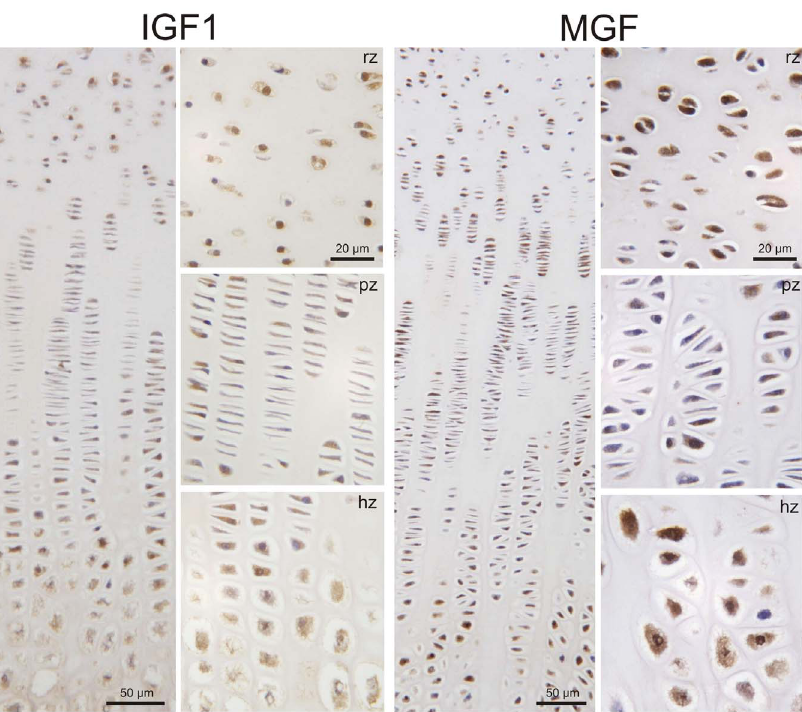
Figure 4. Immunohistochemical detection of MGF and IGF-1 in the porcine growth plate (overview, magnification 10x). MGF and IGF- 1 was detected in chondrocytes of the resting (rz), proliferating (pz) and hypertrophic (hz) zone of porcine growth plate. We found the MGF peptide in the cytoplasm and in some chondrocytes also in the nucleus of resting and hypertrophic chondrocytes, although some cells were completely negative. More negative cells were detected in the proliferating zone (magnification 50 6 ).